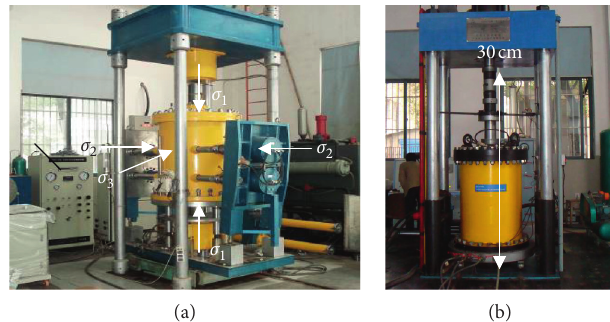
Figure 3: Sample components.